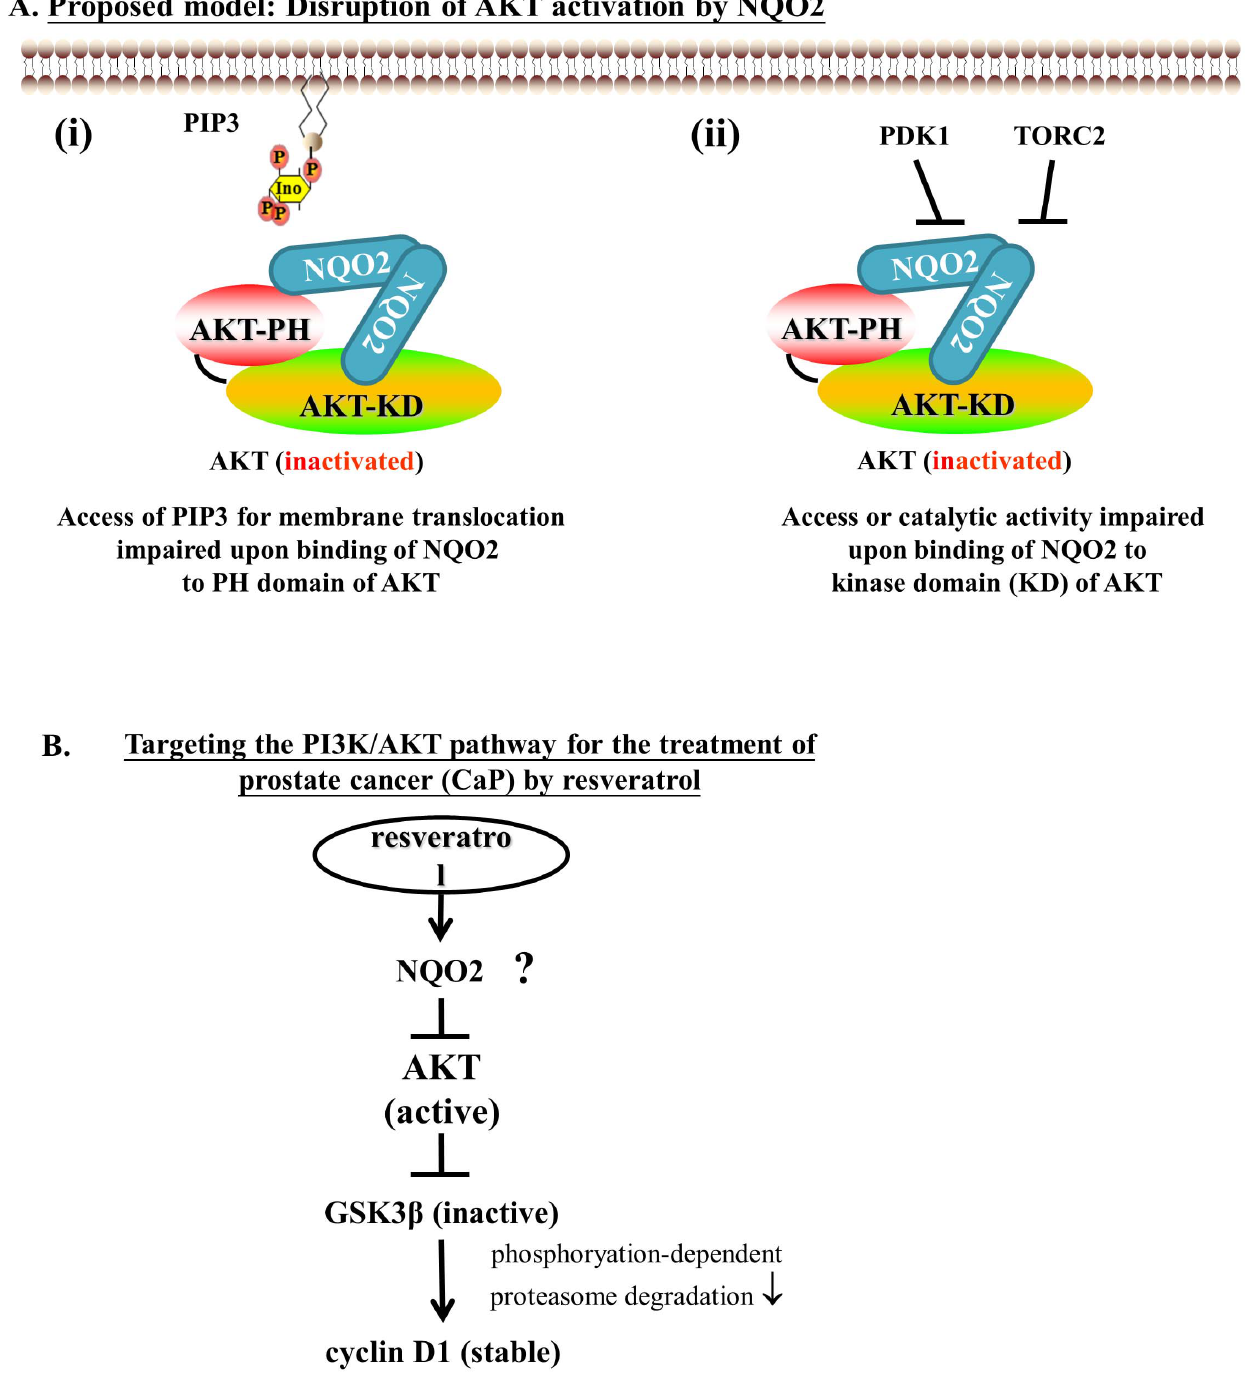
Figure 5. A proposed mechanism on the role of NQO2 in regulating AKT and AKT-mediated signaling events. ( A ) Hypotheses: NQO2 acts as a physiologic partner and modulator of AKT by disruption of its activation. NQO2/AKT interaction may (i) disrupt or limit the access of PIP3 for membrane translocation by AKT or (ii) inhibit the catalytic activity of AKT. ( B ) NQO2 regulates GSK-3 b -mediated cyclin D1 degradation by binding AKT and/or inhibiting its phosphorylation-dependent activation. This sequence of events is effectively attenuated in NQO2 knockdown cells or when cells are exposed to resveratrol, which acts by effectively binding and sequestrating NQO2, rendering it incapable of forming a complex with AKT.